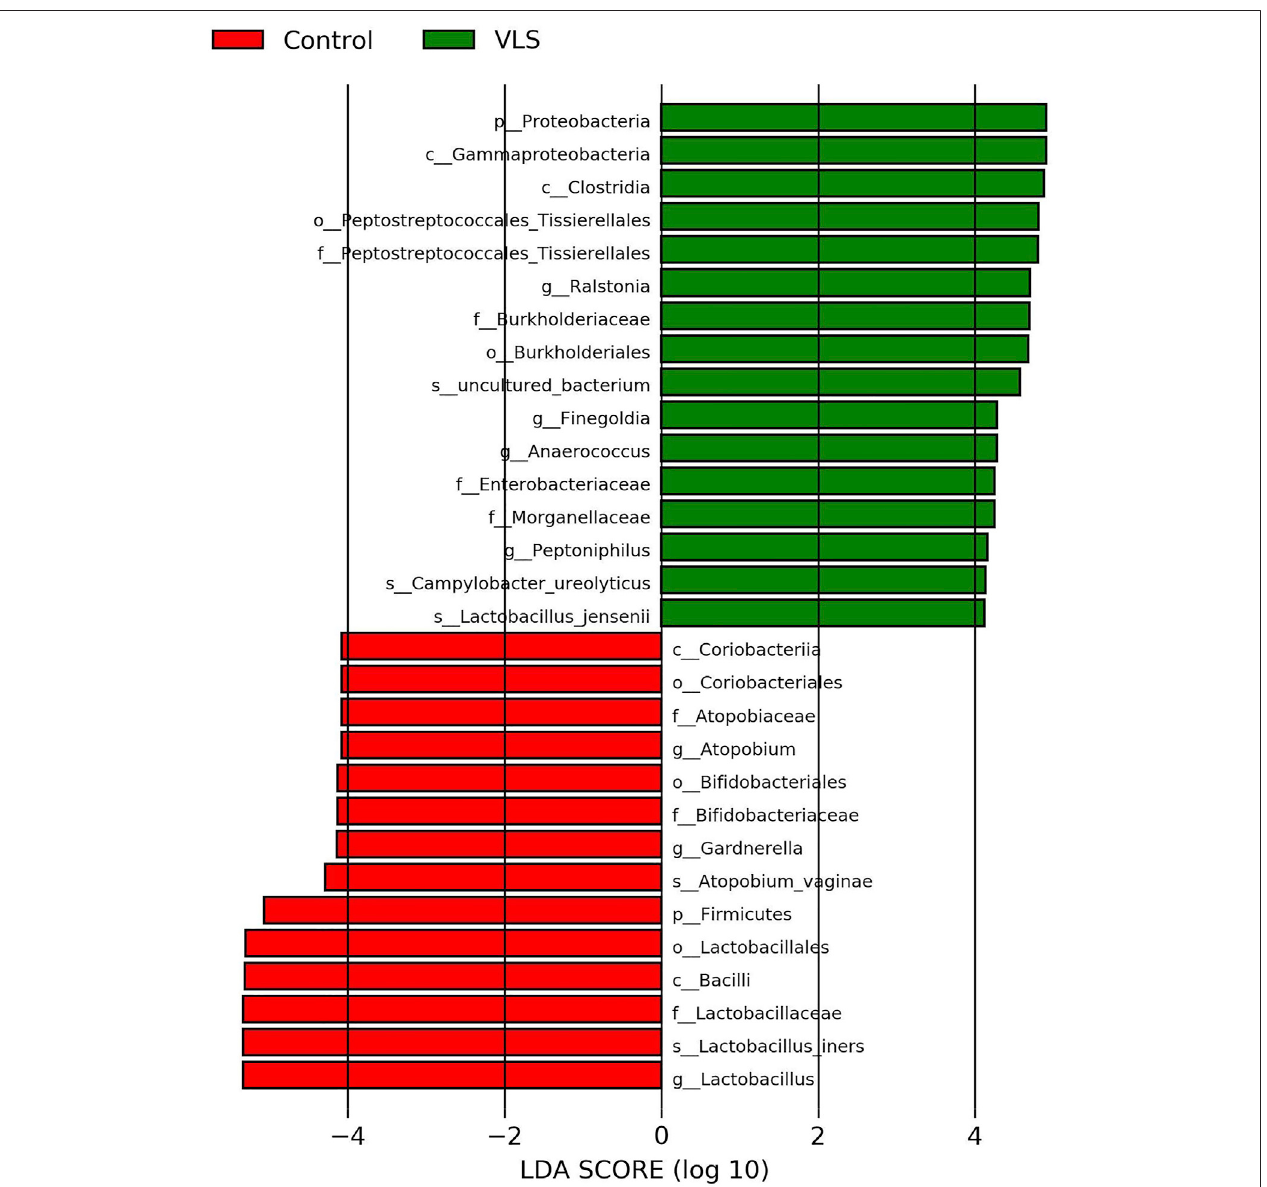
FIGURE 6 | LEfSe analysis of the VLS group and control group (LDA > 4.0).